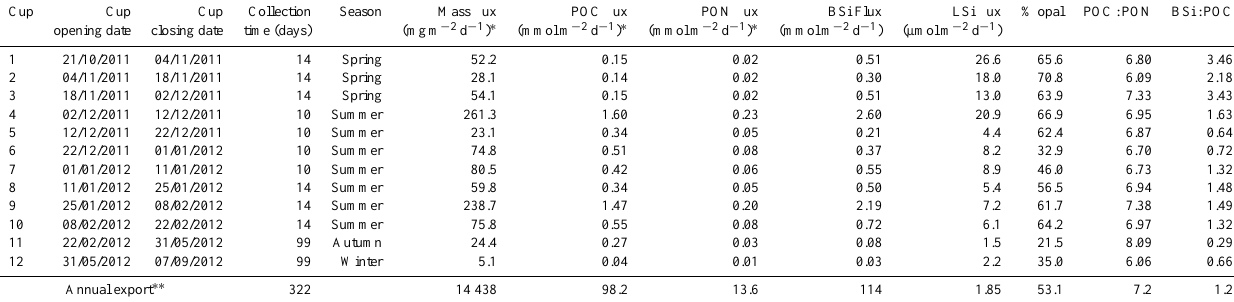
Table 1. Sediment bulk flux and composition results. Cup Cup Cup